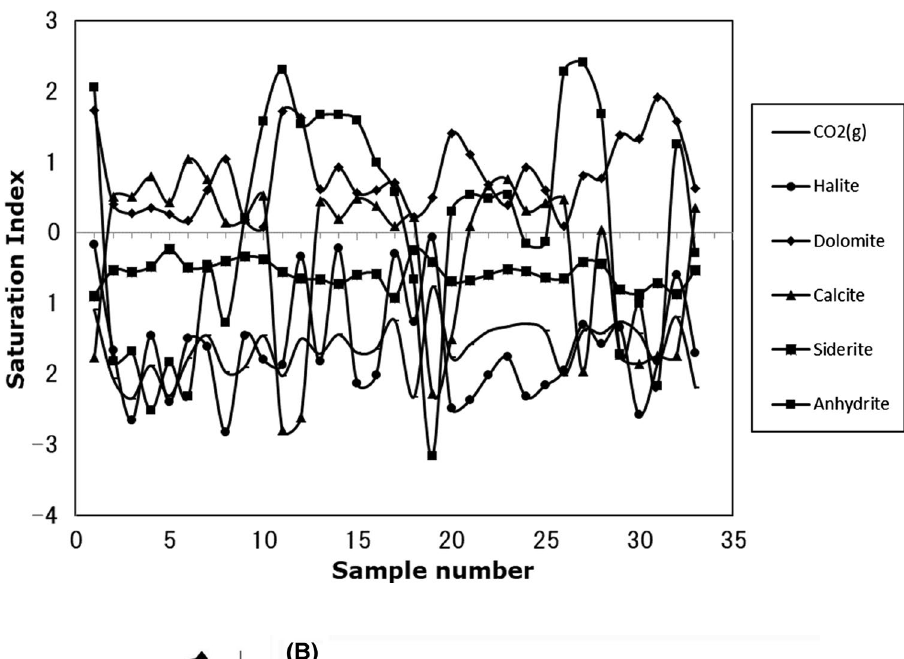
Fig. 9 Summary for saturation indexes for six selected minerals for the water samples